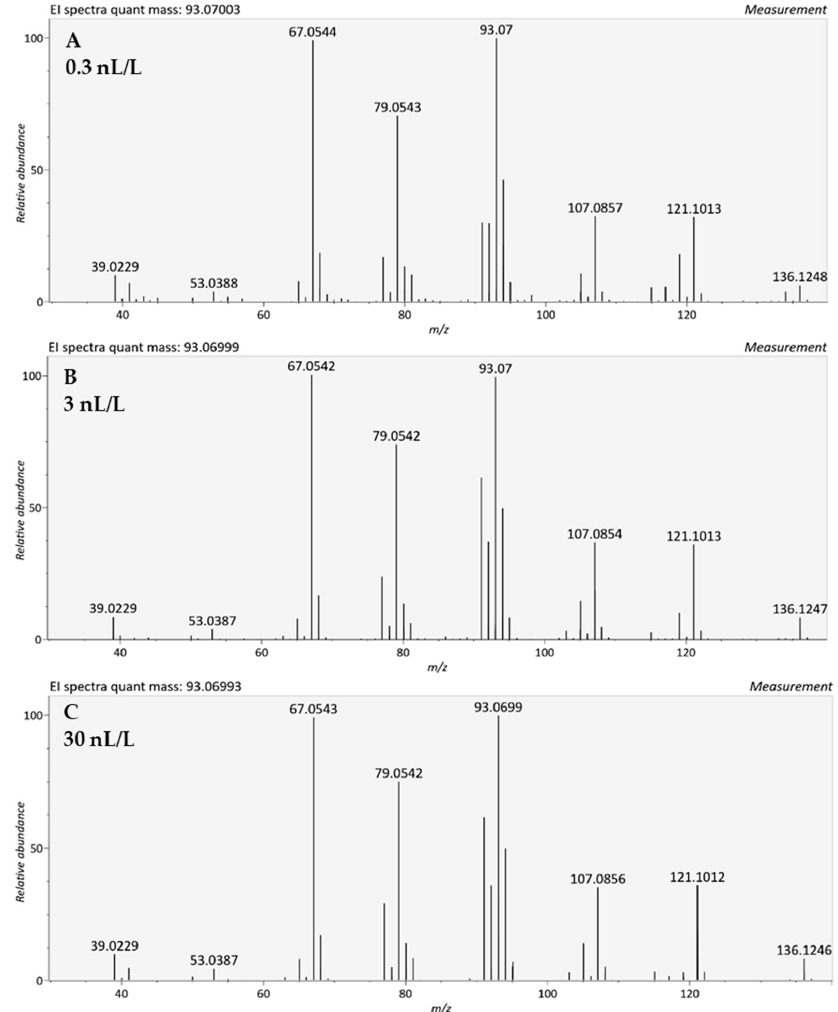
Figure 2. Limonene spectra using TD-GC-MS (Orbitrap) at three different concentrations. ( A ) 0.3 nL/L, where the dominant ion is m/z 93.070; ( B ) 3 nL/L, where the dominant ion is m/z 67.0541; ( C ) 30 nL/L, where the dominant ion is m/z 93.070.